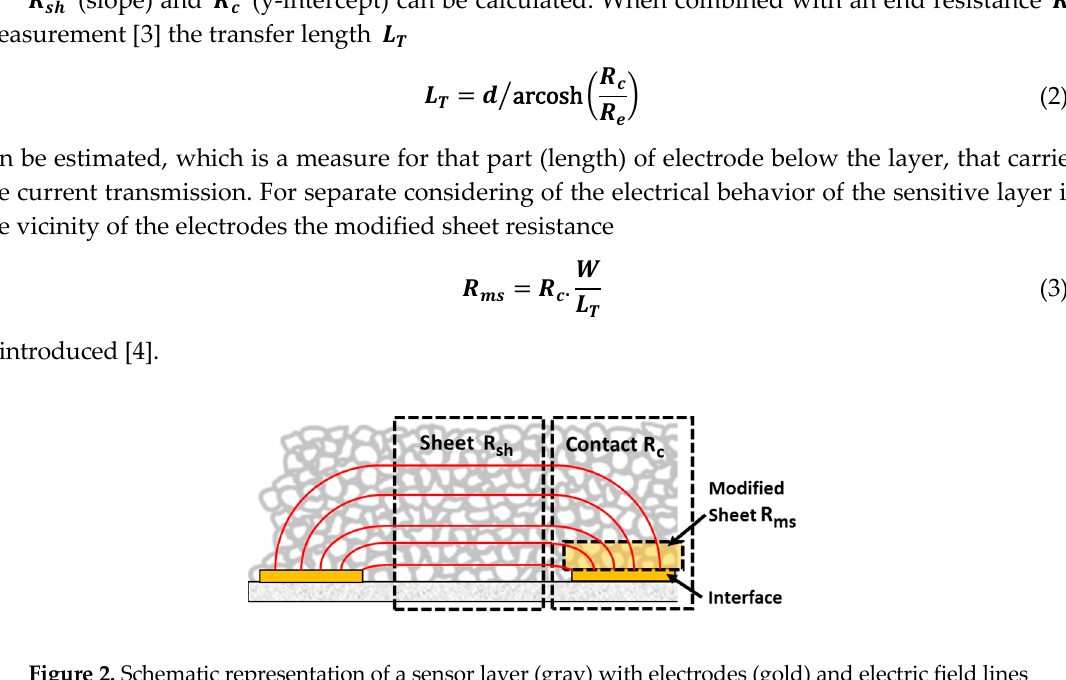
Figure 2. Schematic representation of a sensor layer (gray) with electrodes (gold) and electric field lines (red). The marked areas represent regions of individual electrical contribution to the overall